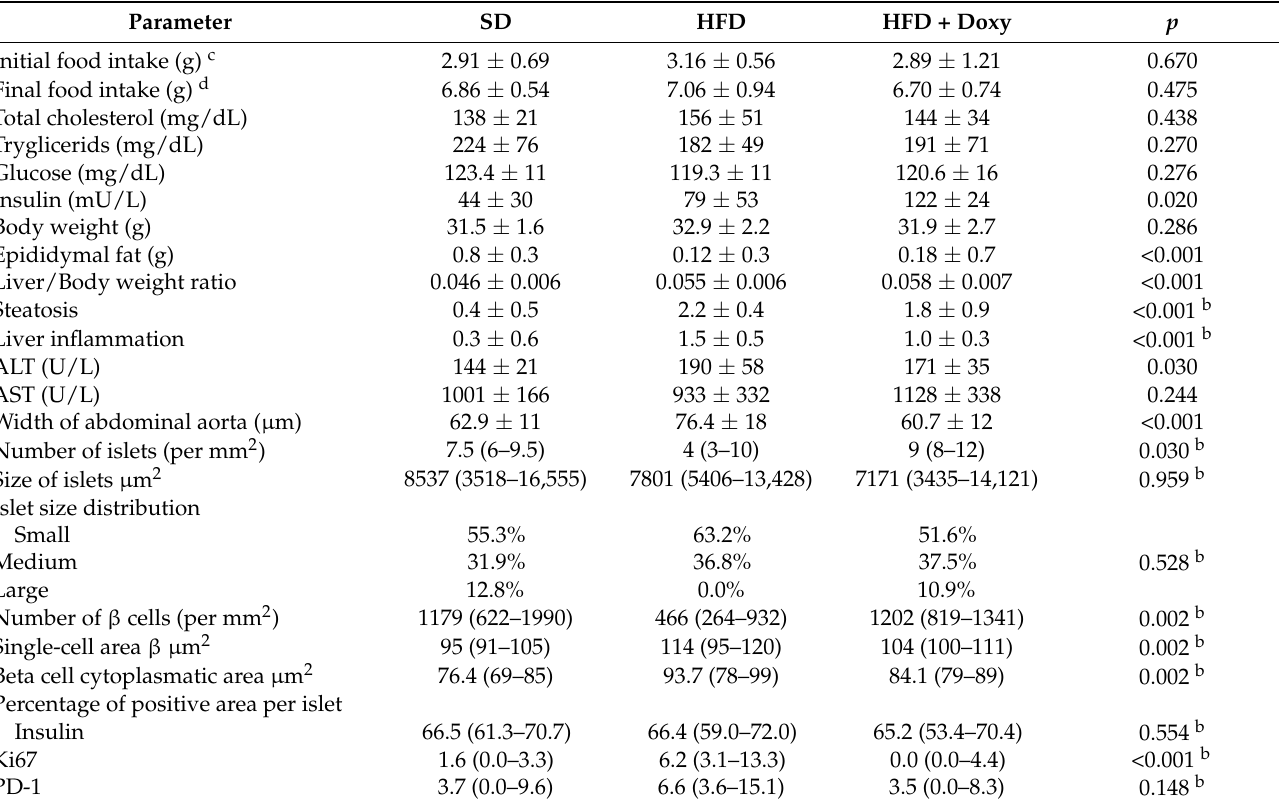
Table 1. Comparison of phenotypes and serum biochemical profiles between healthy mice (SD), fed with a high-fat diet for six months without doxycycline (HFD), and those with a high-fat diet and doxycycline (HFD +